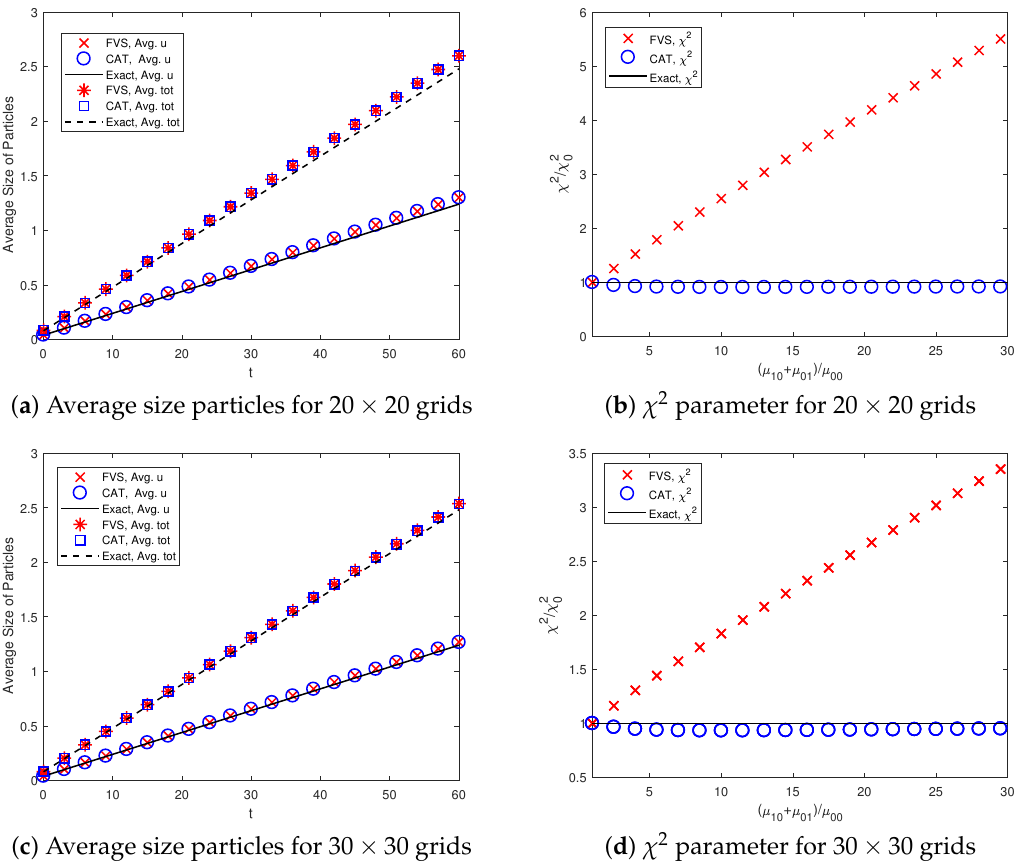
( d ) χ 2 parameter for 30 × 30 grids